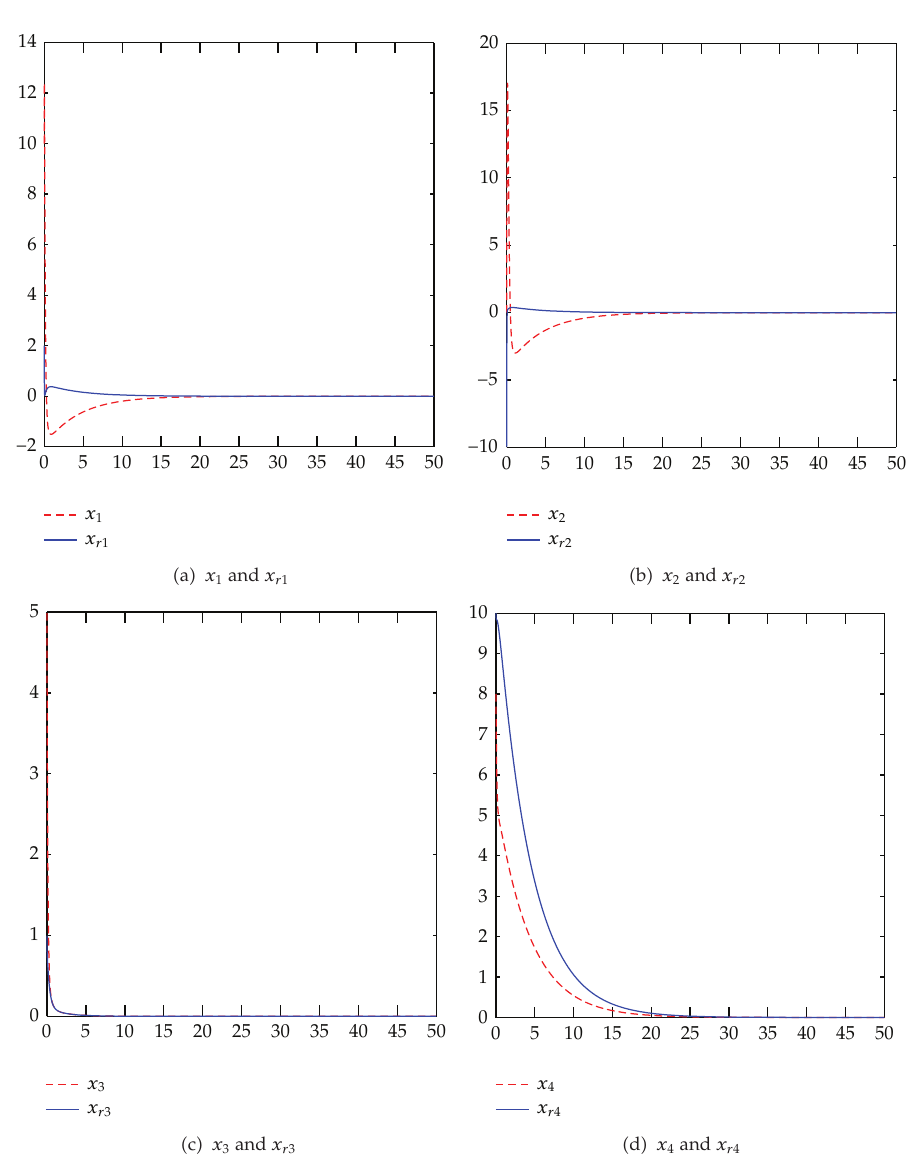
Figure 2: Comparison of the corresponding variables in the controlled hyperchaotic Lorenz system and its reference system: (cid:6) a (cid:7) x 1 and x r 1 ; (cid:6) b (cid:7) x 2 and x r 2 ; (cid:6) c (cid:7) x 3 and x r 3 ; (cid:6) d (cid:7) x 4 and x r 4 . The estimation system of uncertain parameters